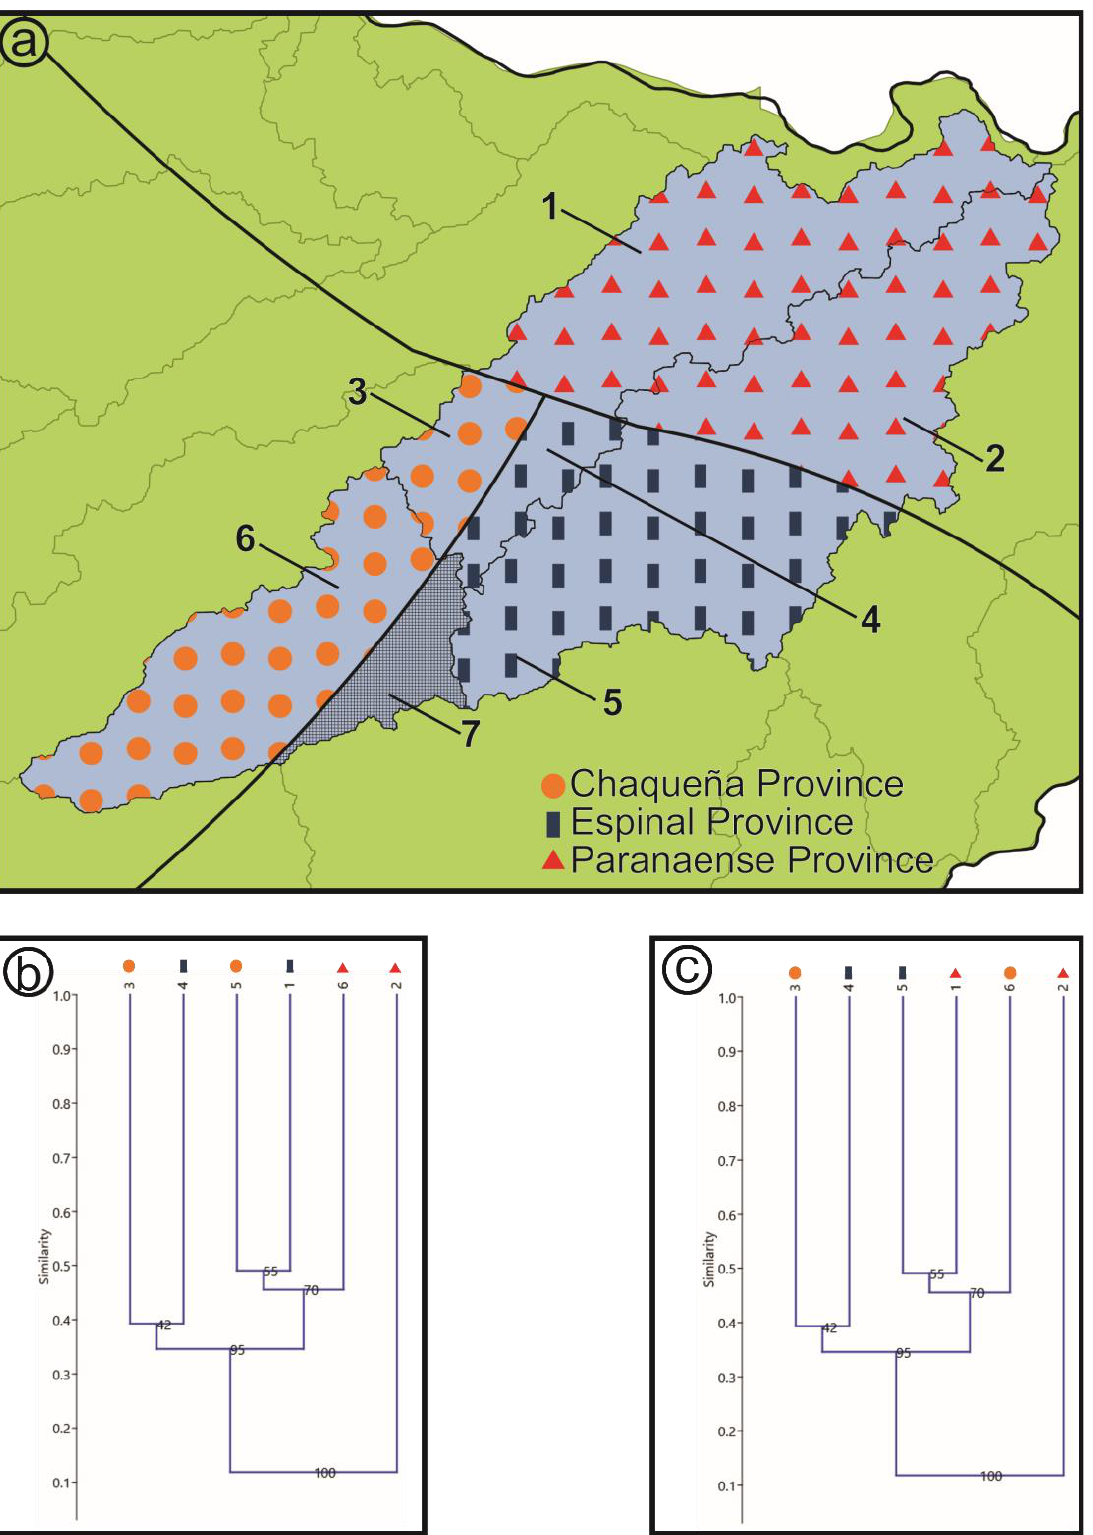
Figure 6. ( a ) Iberá Depression divided by the biogeographic provinces, ( b ) Dendrogram showing similarity between areas (Sorensen–Dice), ( c ) Dendrogram showing similarity between areas (Jaccard). The dendrograms showed a cophenetic correlation (CC) > 0.96.